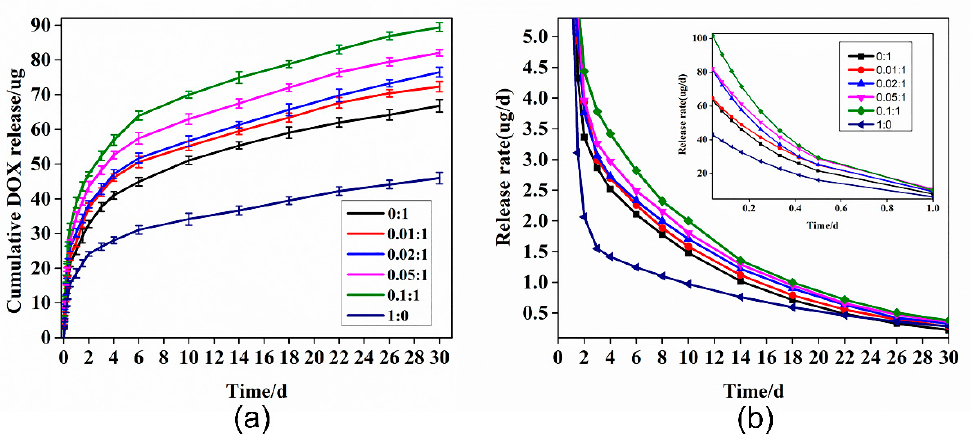
Figure 11. Release profiles of doxorubicin (DOX) from DOX-loaded nanocomposites prepared from the different addition amounts of c-MWCNTs (tube diameter <8 nm, length 0.5~2 μ m) in the MPEG-PDLLA/c-MWCNT mixed solutions: ( a ) cumulative DOX release from drug-loaded micelles and ( b ) the DOX release rate. Data are shown as means ± S.D. ( n = 6).